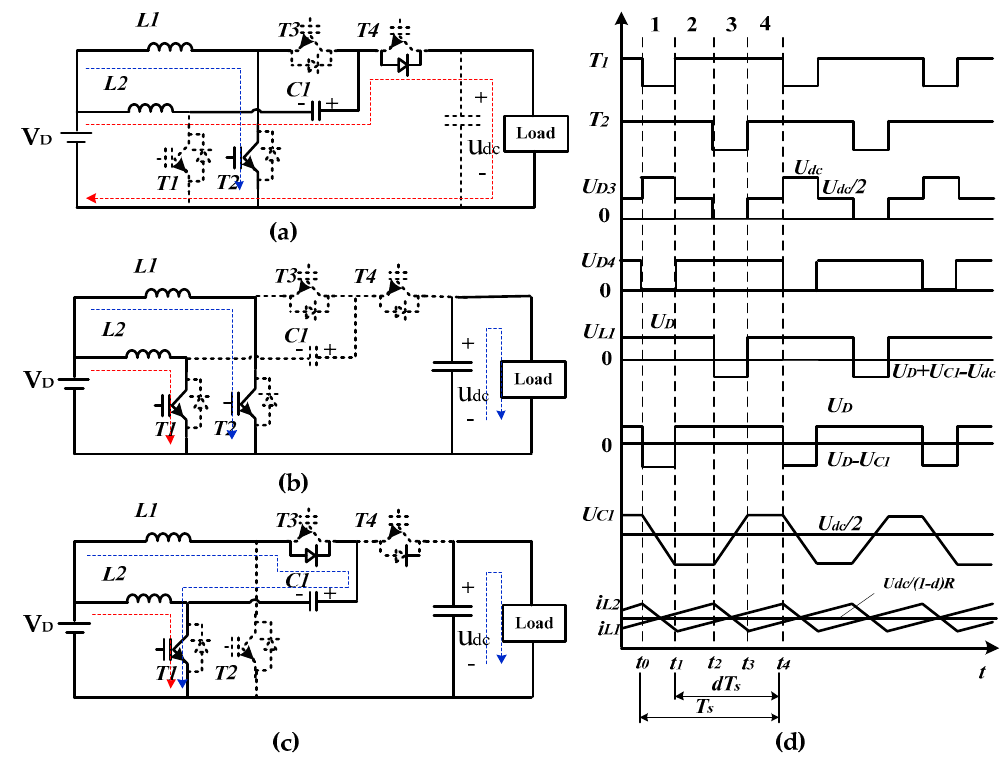
Figure 7. The working principle of the DC-DC converter: ( a ) the equivalent circuit of DC-DC converter in mode 1.; ( b ) the equivalent circuit of DC-DC converter in mode 2&4; ( c ) the equivalent circuit of DC-DC converter in mode 3; ( d ) The main waveform of the circuit in the boost mode.